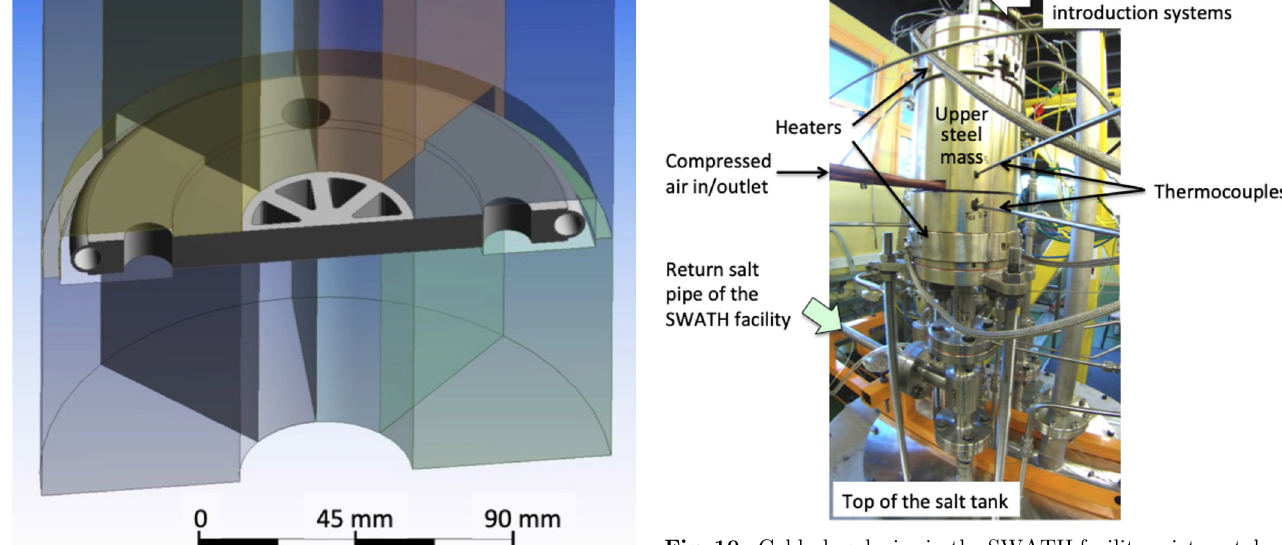
Fig. 10. Cold plug device in the SWATH facility, picture taken before thermal insulation of the system.